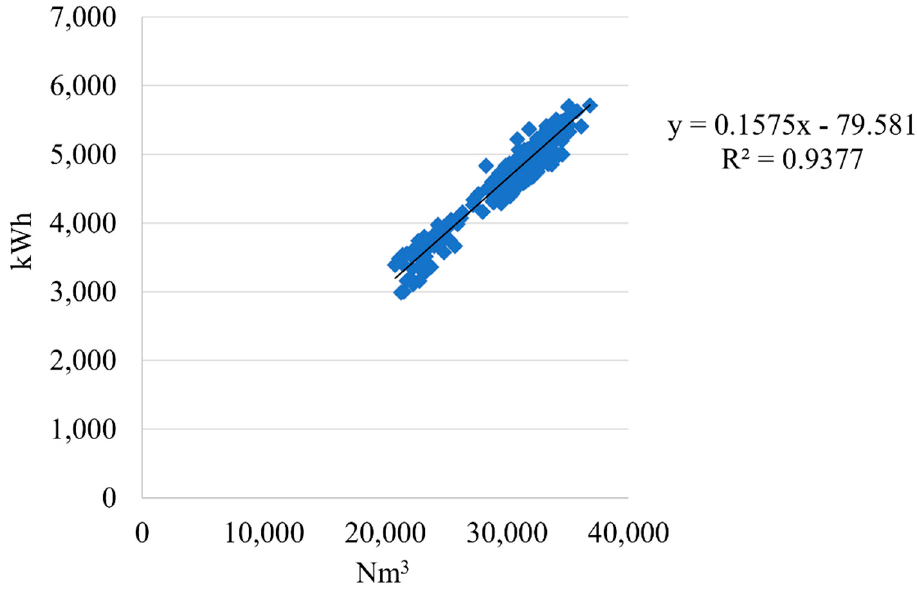
Figure 8. Scatterplot representing the relation between energy consumption and compressed air production.